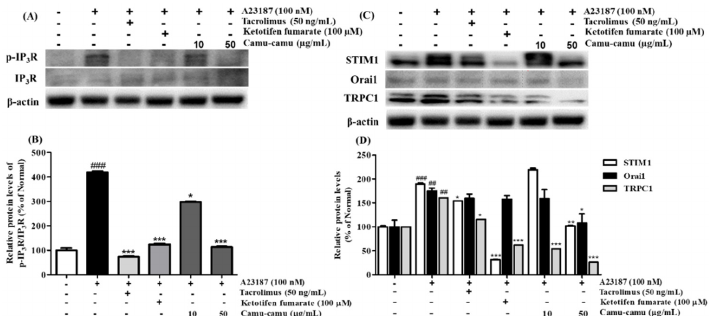
Figure 6. Effect of camu-camu fruit extract on IP 3 R phosphorylation ( A , B ) and calcium channel proteins ( C , D ) in A23187-induced RBL-2H3 cells. Band intensities were quantified by densitometry, normalized to the level of β -actin. Then, it was calculated as the percentage of the untreated cells and displayed as mean ± SD of three independent experiments ( ## p < 0.01 and ( ### p < 0.001 vs. the control group, * p < 0.05, ** p < 0.001 and *** p < 0.001 vs. the A23187-treated group).